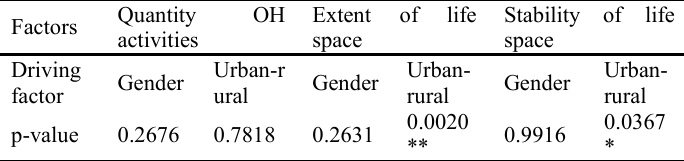
Table 4 .The results of the Mann-Whitney U test for the